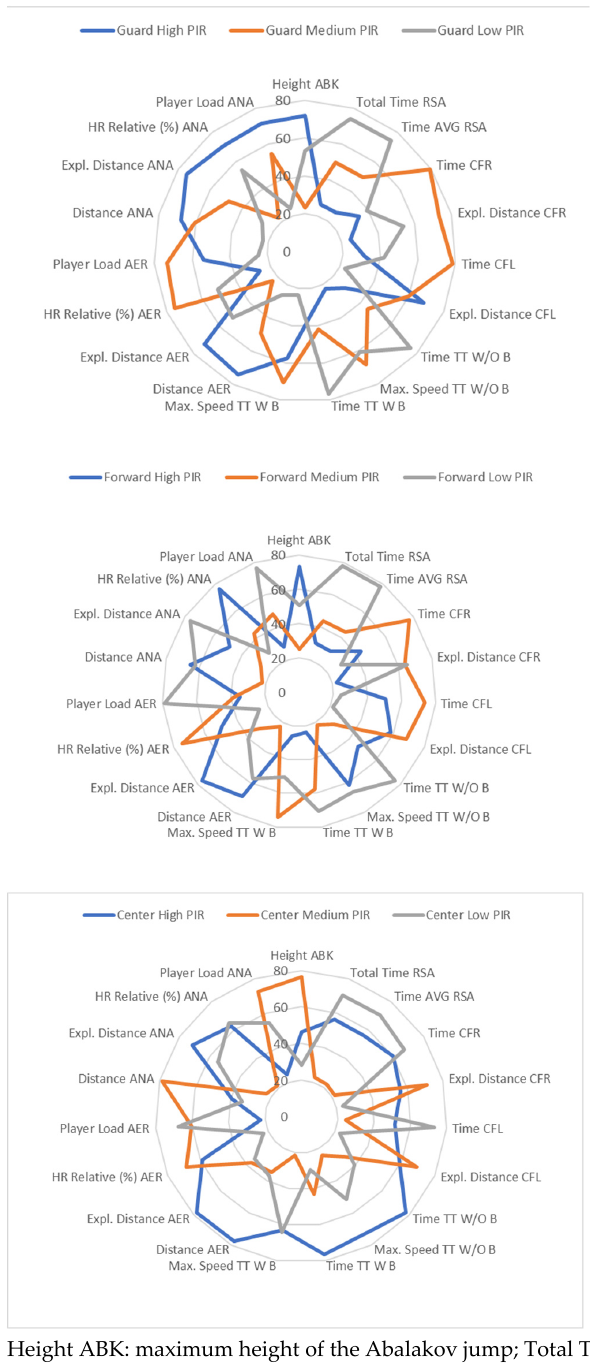
Figure 2. Physical profiles of players according to their performance in the game, by playing